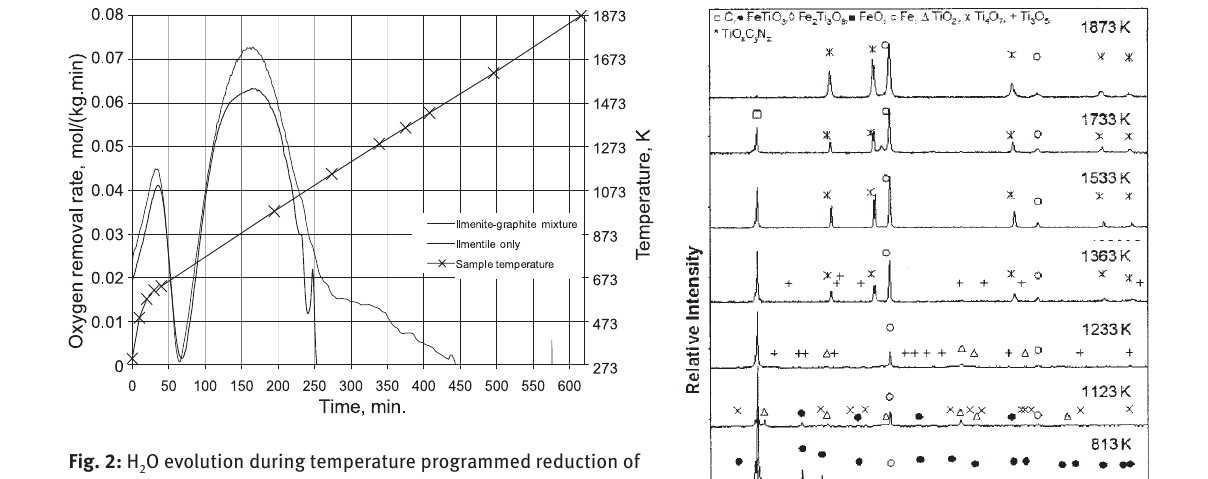
-N gas mixture at 623–1873 K . 2 2